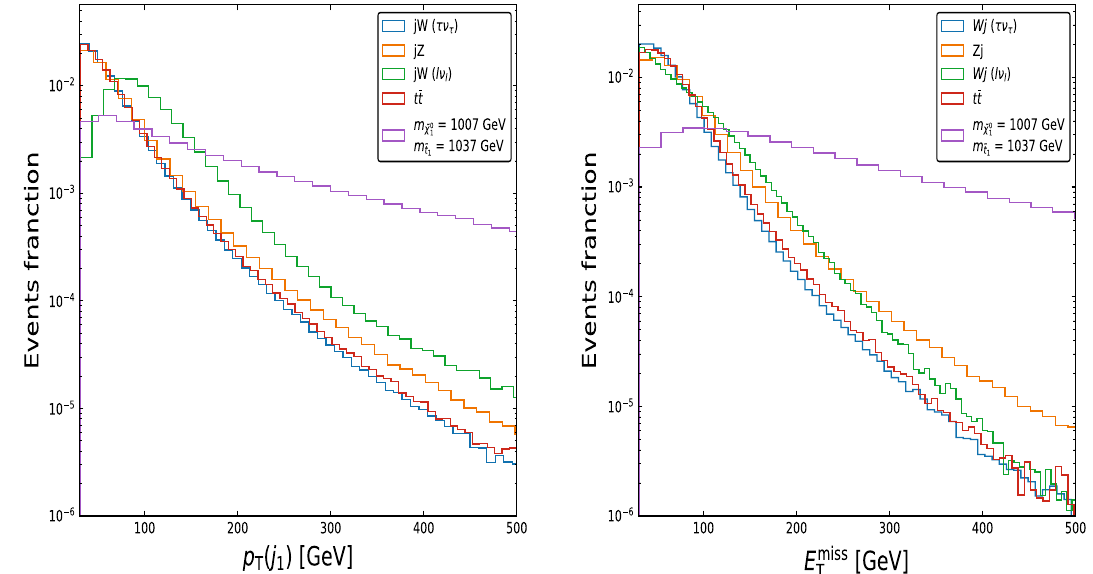
Fig. 8 The normalized distributions of the leading jet p T ( j 1 ) and E miss = 1037 GeV and m = 1007 is m ˜ t ˜ χ 0 1 1